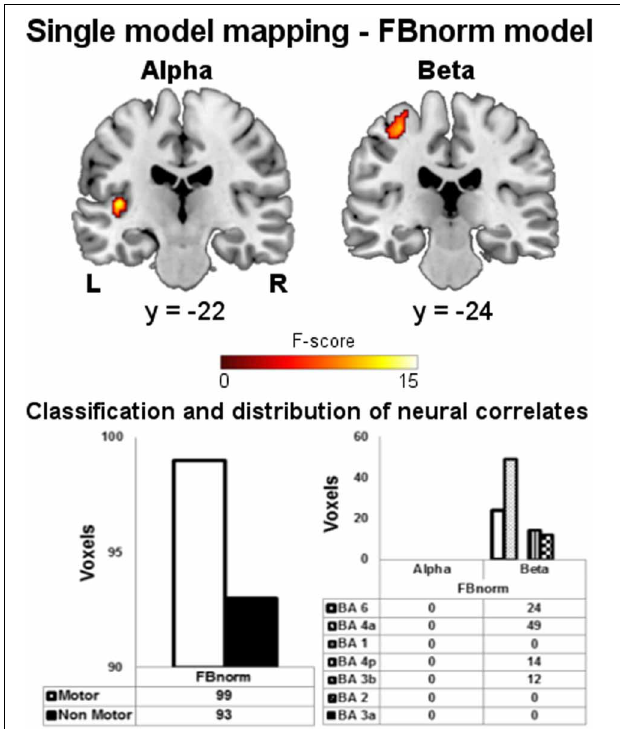
FIGURE 5 | Single model mapping—FBnorm model. Top panel: group maps obtained from single model mapping using FBnorm model. Neural correlates for alpha and beta rhythms are shown ( p < 0 . 001, uncorrected). Bottom panel: (left) voxels classification according to the BAM; (right) distribution of “motor” voxels among the Brodmann areas identified by the SO analysis. The number of voxels assigned to the classes are tabulated below